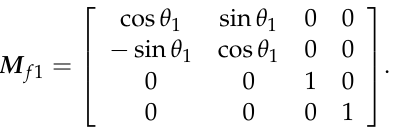
Figure 10. Pitch curve coordinate system of the curve face gear pair.